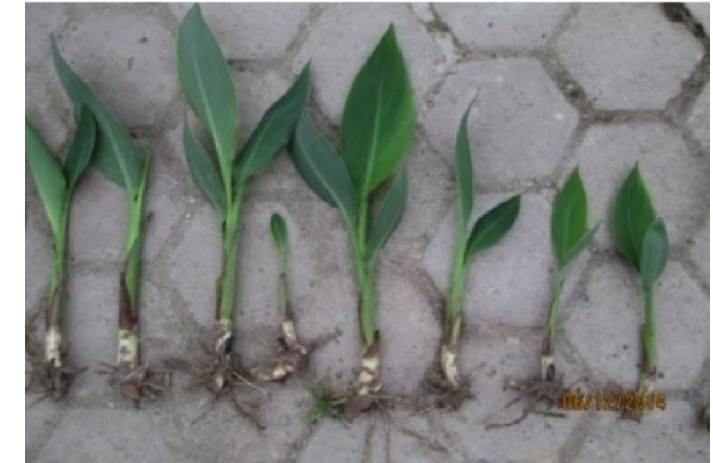
Fig. 1: Seeding Cannas generalis